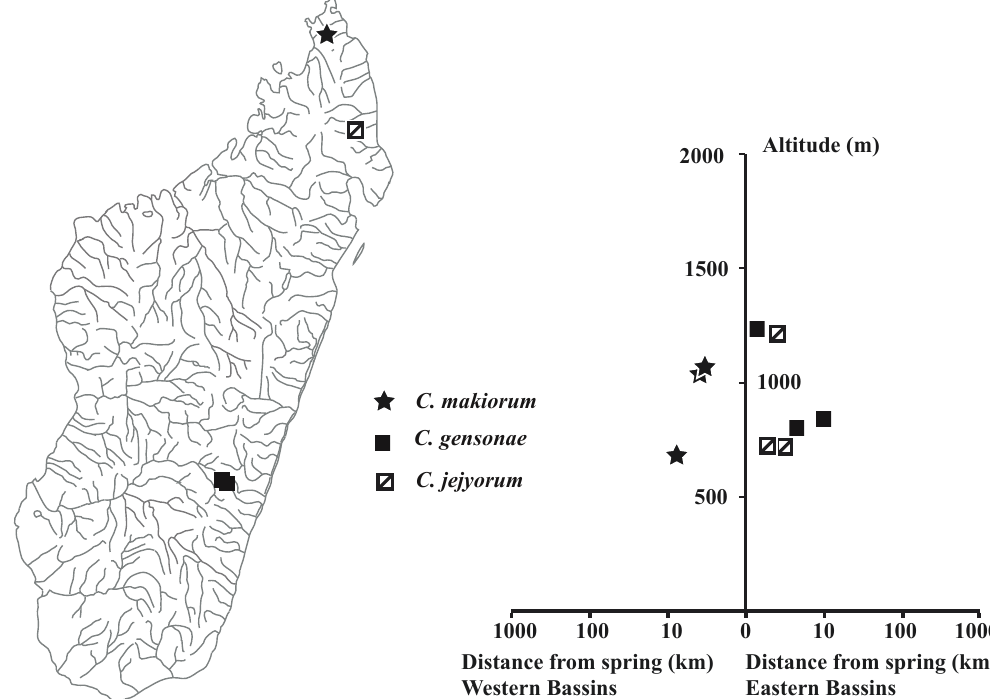
Fig. 18. Chimarra makiorum sp. nov., Chimarra gensonae sp. nov. and Chimarra jejyorum sp. nov., schematic distribution map and ecological profile of the capture sites in